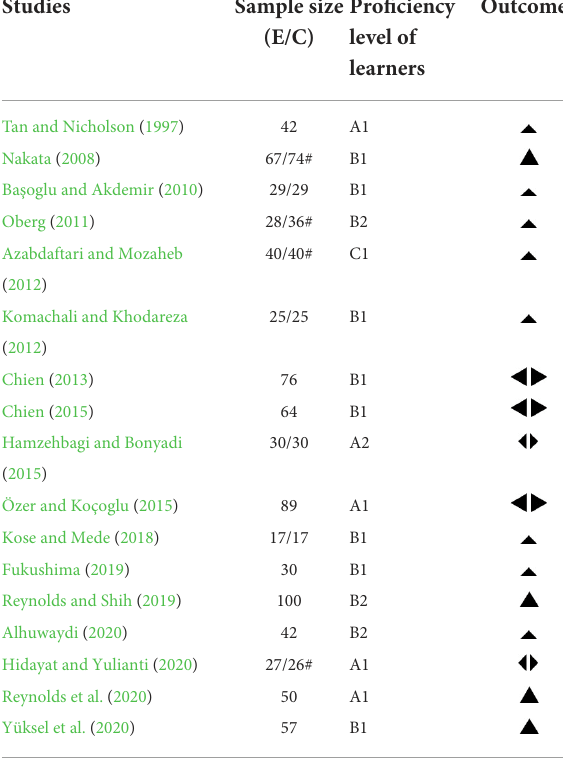
TABLE 7 Effect direction plot for proficiency level of learners ( k =